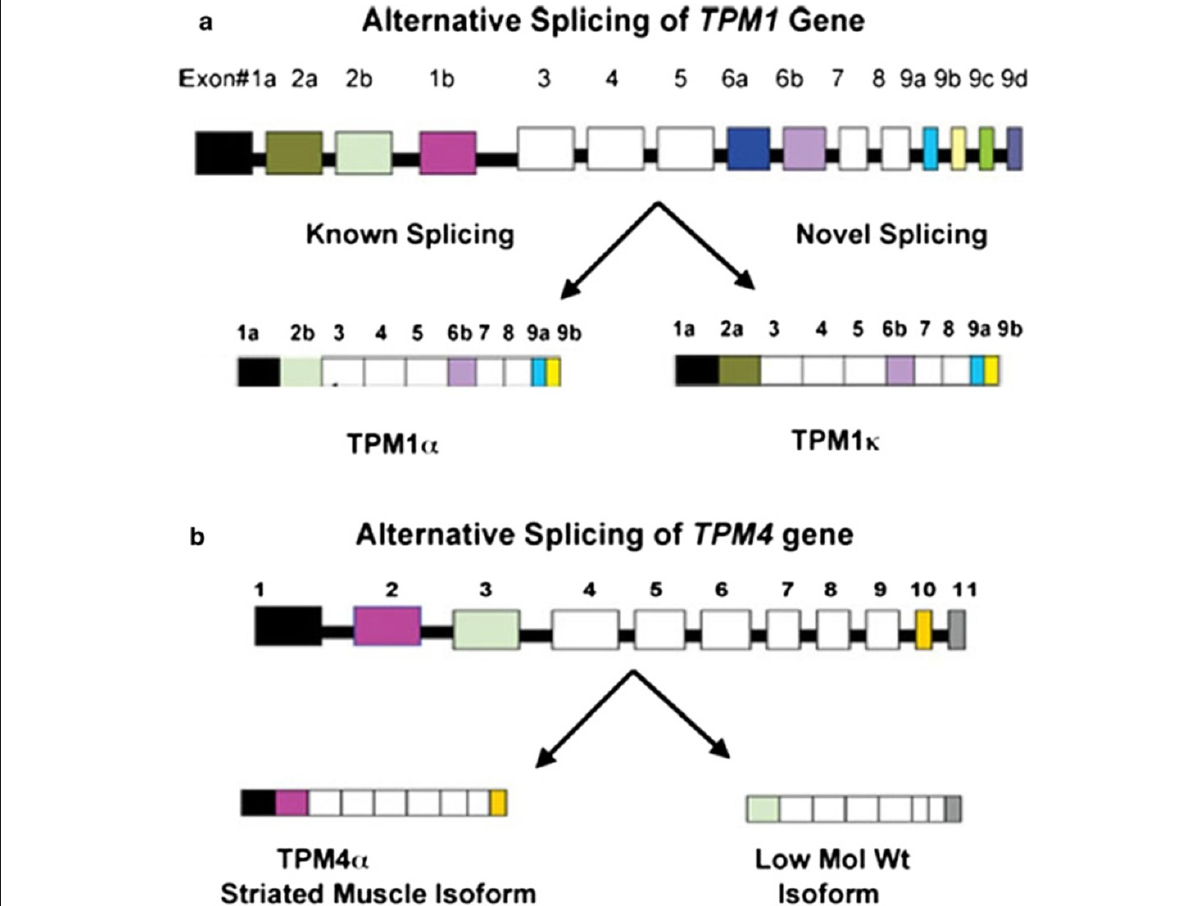
Figure 1 Alternative splicing patterns of TPM1 and TPM4 genes. (a) Exon composition of the TPM1 gene and alternative splicing that generates two striated muscle specific isoforms -TPM1 α and TPM1 κ [26]. (b) Exon composition of TPM4 gene (adapted from avian species as proposed by Fleenor et al. [30] and alternative splicing generate two isoforms in axolotl, TPM4 α and a low-molecular weight TPM4